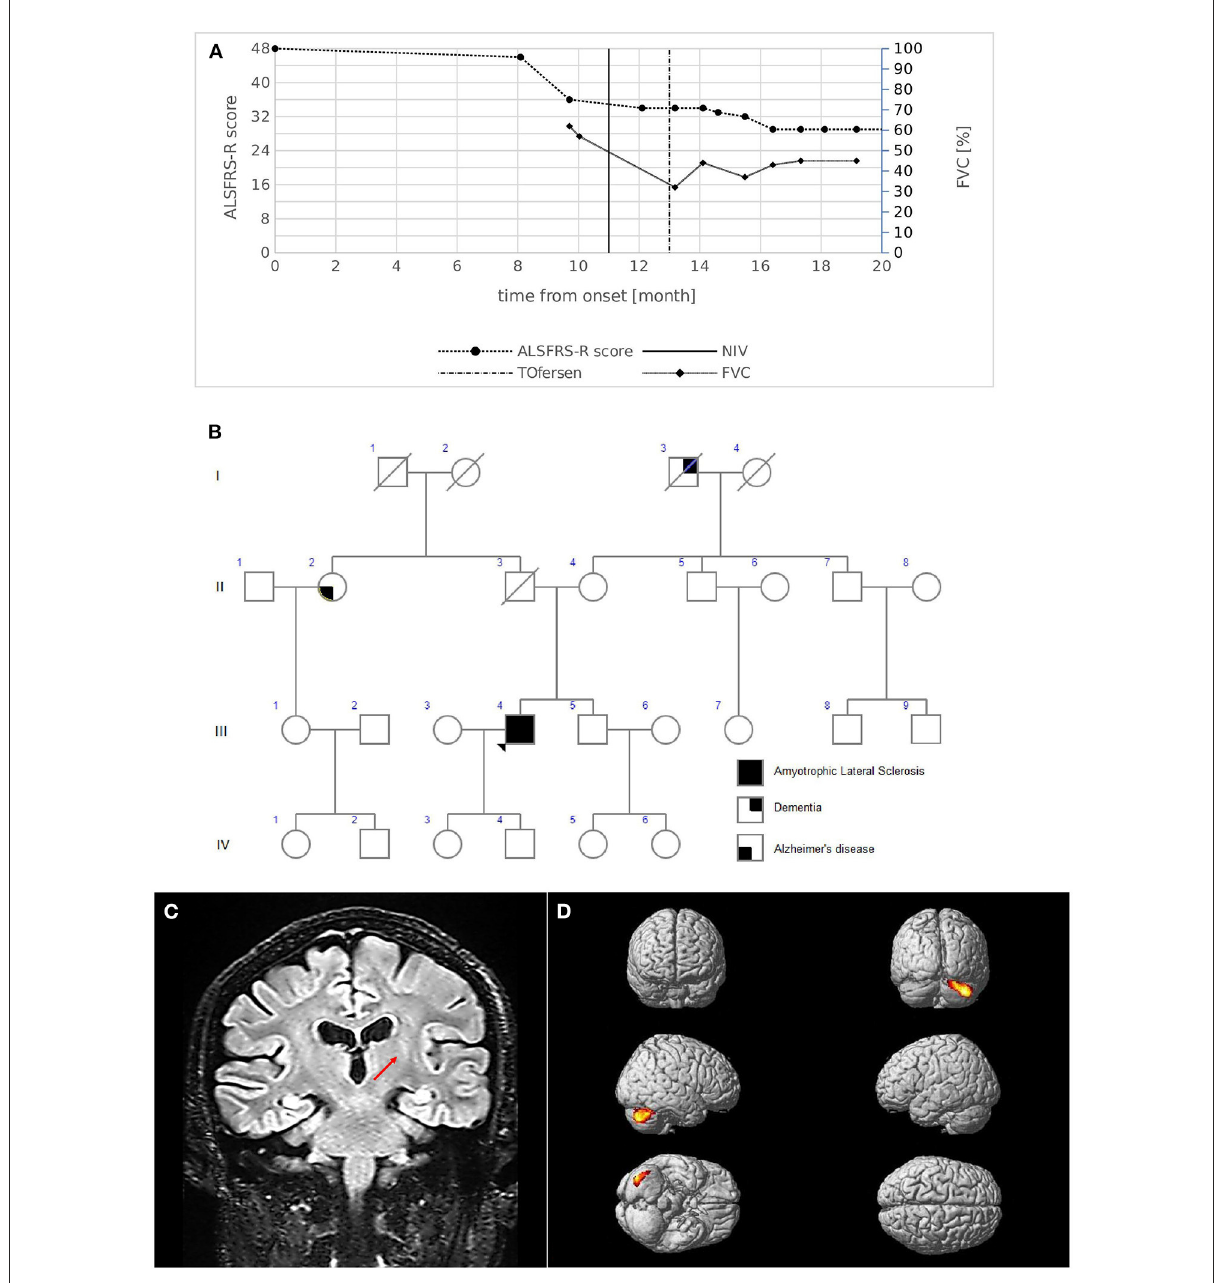
FIGURE2 (A) Disease course of case 2. The graph shows ALSFRS-R total score (left) and FVC % (right) decline from the onset of symptoms. The bold vertical line represents the time when NIV was initiated, while the dashed vertical line represents the beginning of intrathecal Tofersen administration. (B) Family pedigree of case 2. Filled circle/square, affected individuals; open circle/square, unaffected individuals; arrow, proband; diagonal line, deceased individuals. The proband’s father died at 56 years of age of colon cancer; the mother is still alive; a 51-year-old brother is alive and in good health and is currently undergoing psychological counseling to evaluate genetic testing. Maternal grandfather had dementia which started at an advanced age; a paternal aunt had Alzheimer’s disease with onset at 75 years. (C) MRI coronal acquisition showing FLAIR hyperintensity of left cortico-spinal bundle; the red arrow indicates the peculiar involvement of the internal capsule segment. (D) 18 FDG-PET images Glass brain rendering of the comparison between subject 2 and 40 healthy controls (HC). The cluster showing a statistically significant relative hypermetabolism in subject 2 compared to HC is projected on the brain surface (height threshold p < 0.001; p < 0.05 FWE-corrected at cluster level). For 18 F-FDG-PET acquisition and elaboration details please refer to Canosa et al. (12) and Supplementary